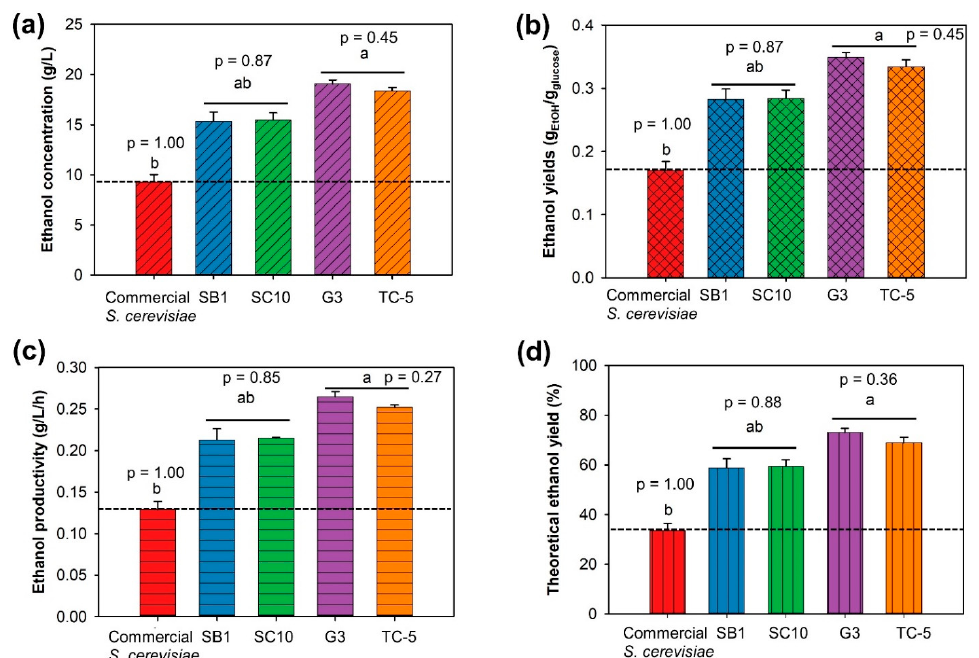
Figure 1. Comparison of ethanol concentration ( a ), ethanol yield ( b ), ethanol productivity ( c ), and theoretical ethanol yield ( d ) from cellulose-rich corncob hydrolysate by four thermotolerant yeasts and commercial S. cerevisiae at 42 °C for 72 h. Note: values are presented as mean ± standard deviation. Different letters above the bars denote statistically significant different. Bar chart with the same pattern and letter are not significantly different. The level of significance was tested by Duncan’s multiple range test. (Each kinetic value (ethanol concentration, ethanol yield, ethanol productivity, or theoretical ethanol yield) was compared between yeast strains).